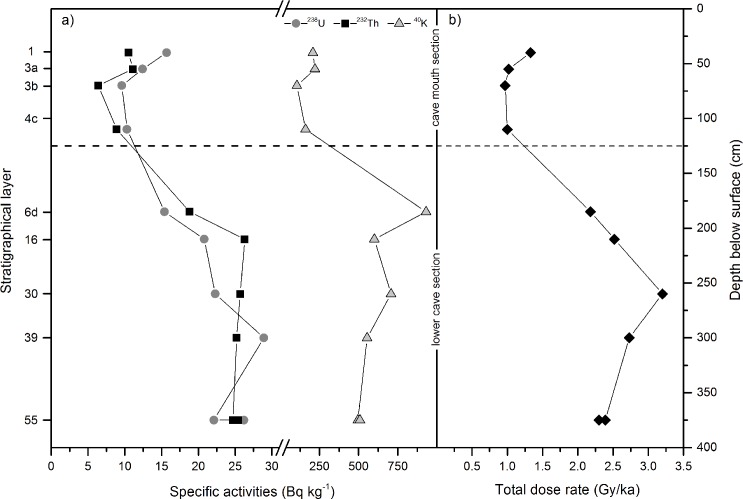
Determined dose rate changes throughout the cave sections at Rhafas.Distribution of (a) radioactive elements 238U, 232Th, 40K and (b) total dose rate for the sampled layers within the cave of Rhafas.